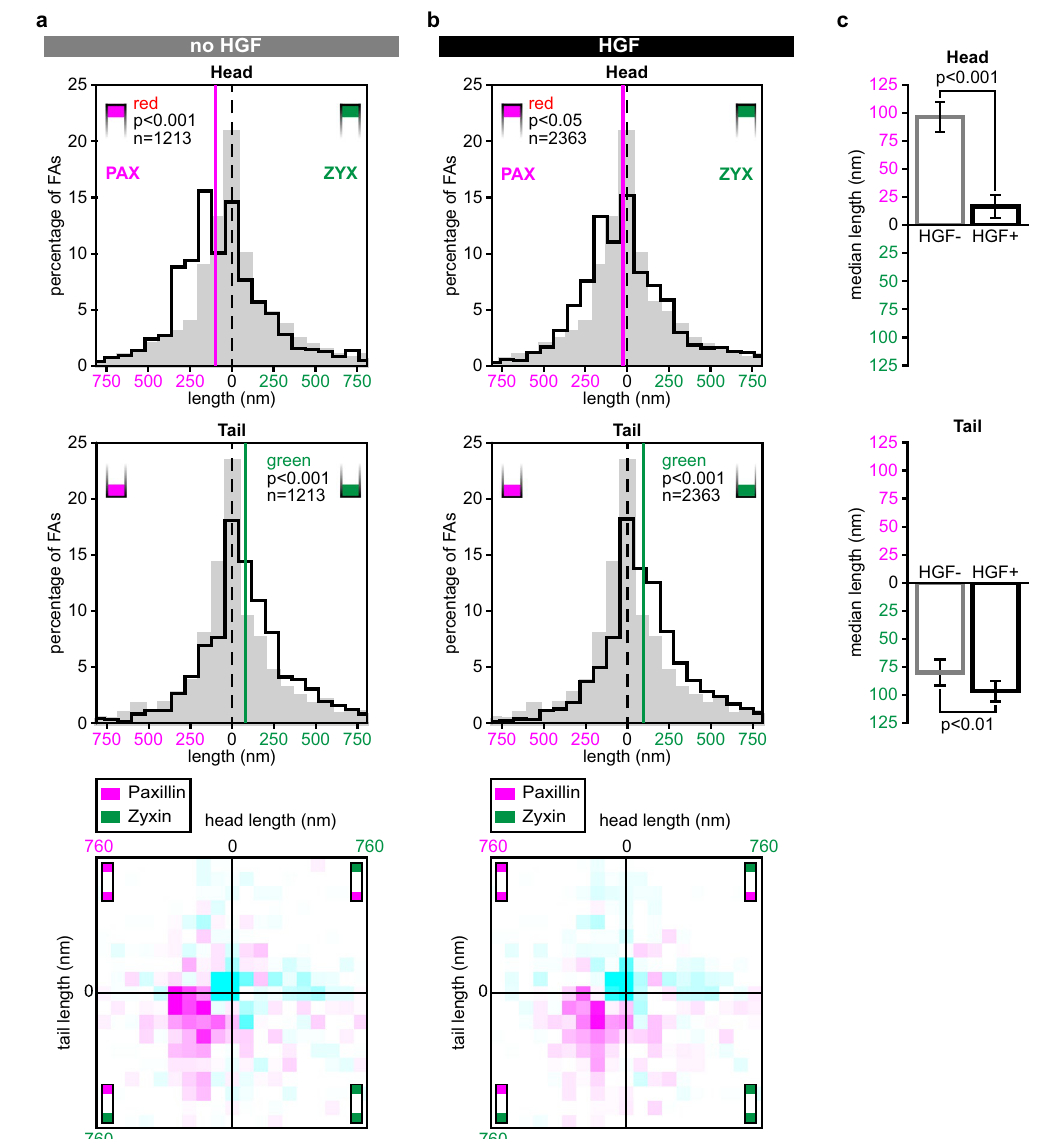
Figure 5. HGF treatment alters the longitudinal distributions of paxillin and zyxin along FAs. ( a ) Histograms of head (top) and tail (middle) protrusion lengths for 12 U2OS cells co-expressing paxillin-mCherry and zyxin-GFP and subjected to overnight serum-starvation. Reference histograms showing measured protrusion lengths in the pax/pax reference set are shown in grey. p values generated compared to the reference set (two- sided Mann Whitney U tests), n gives number of analysed FAs. Vertical lines: medians. Bottom: 2D-histogram combining head and tail protrusion lengths for each individual FA. Colours represent the difference compared to the relative distributions of the reference set. White: below threshold, magenta: increase relative to reference set, cyan: decrease relative to reference set. Colour intensity represents magnitude of the difference (for scale and threshold see Materials and Methods). ( b ) Histograms of head (top) and tail (middle) protrusion lengths for 21 U2OS cells co-expressing paxillin-mCherry and zyxin-GFP, subjected to overnight serum-starvation and treated with HGF at least three hours prior to imaging. Grey histograms, vertical lines, n-numbers and statistical tests as above. Bottom: 2D-histogram combining head and tail protrusion length for each individual FA. Colours as above. ( c ) Comparison of head (top) and tail (bottom) protrusion lengths for the serum starved HGF minus (grey outline) and the serum starved and HGF treated (black outline) cells, p values are generated by two-sided Mann Whitney U tests. Errorbars show standard error of the mean